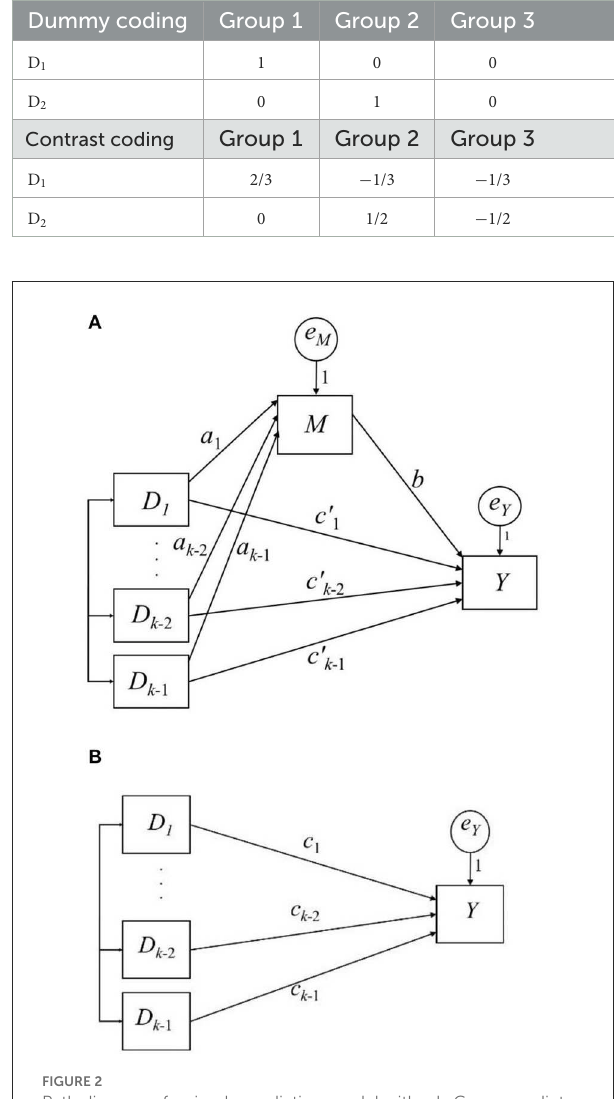
FIGURE2 Path diagram of a simple mediation model with a k-Group predictor and the total effect. (A) shows the simple mediation model; (B) shows the total